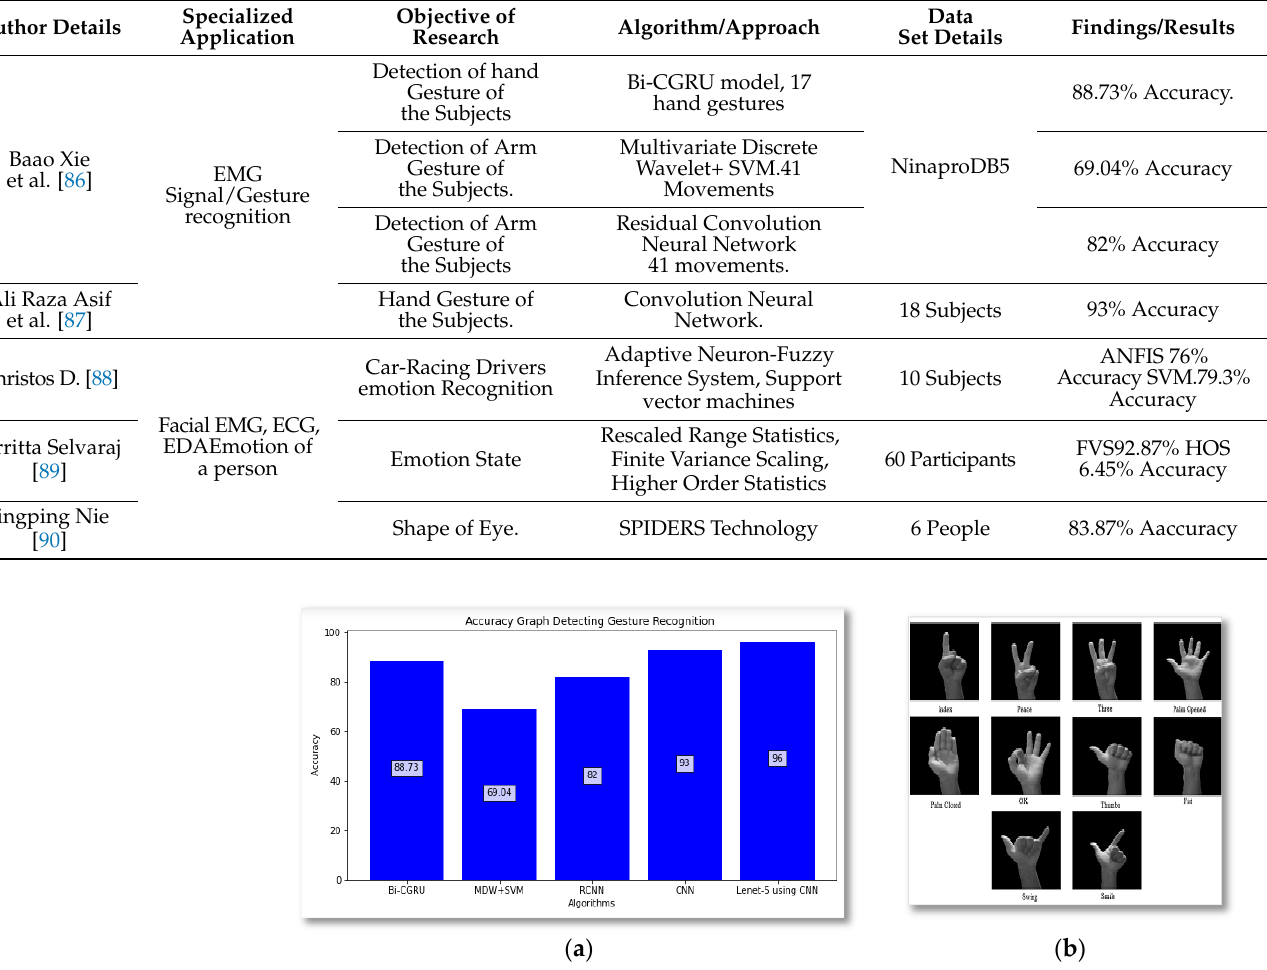
Table 7. Emotion of a person and hand gesture application.